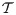
Ratio of CPU times for the combinatorial (T) and the algebraic (T) tests of 2-face cutting.The combinatorial test is the best option for systems that convert into densely-connected graphs while the algebraic test is appropriate for systems converting into sparsely-connected graphs.